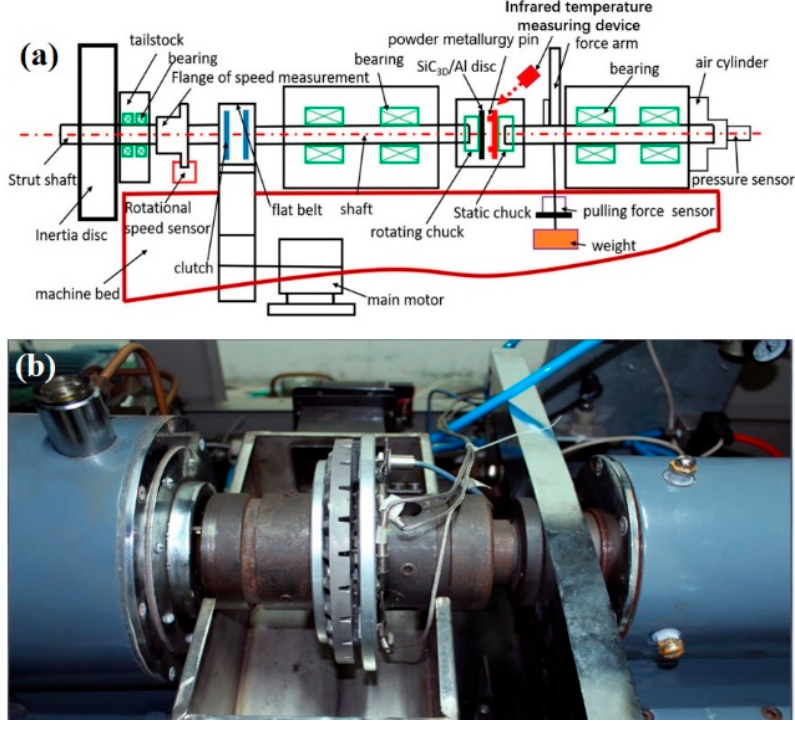
Figure 8. MM3000 sub-scale testing machine: ( a ) schematic diagram; ( b ) photo of experimental equipment. experimental